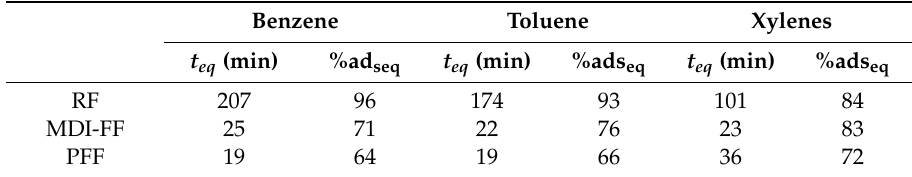
Table 6. Maximum BTX adsorption percentages (%ads eq ) and related time of occurrence ( t eq ) in the water polluted closed